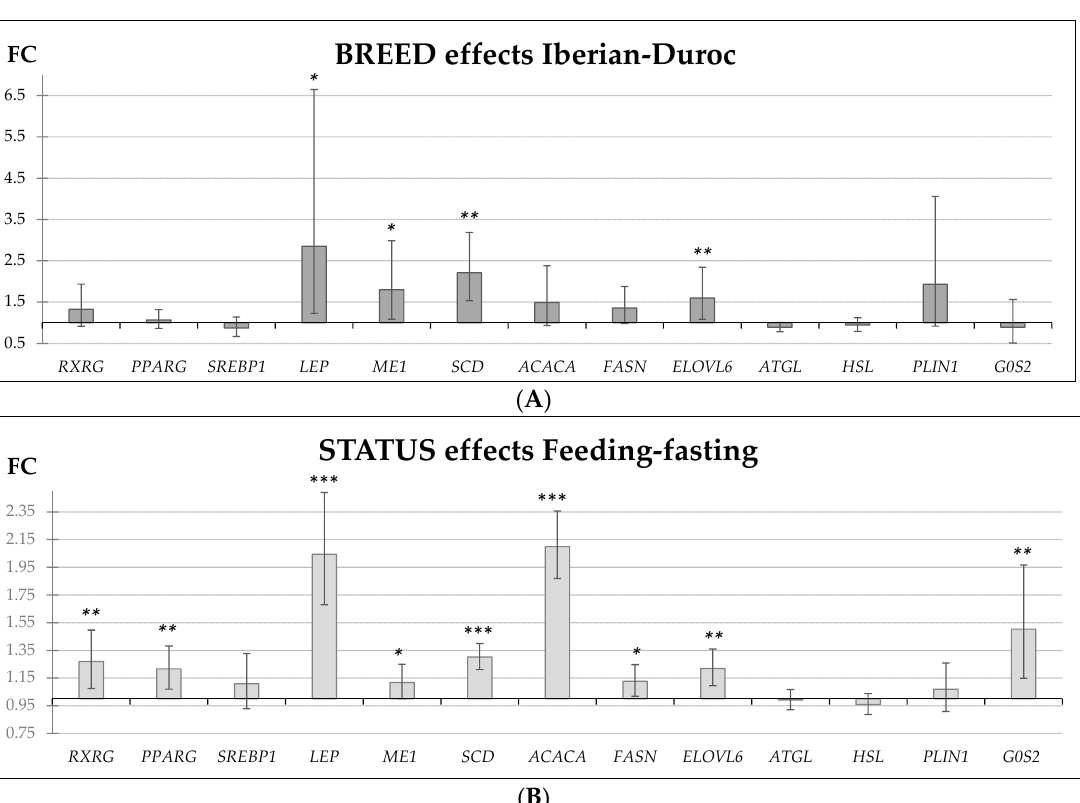
Figure 1. Fold-change ratios (FC) of candidate genes expression in ham subcutaneous adipose biopsies ( A ) Iberian ( n = 29) versus Duroc ( n = 19) ( B ) Feeding versus fasting status ( n = 48). The error lines indicate the standard errors. FC values > 1 indicate higher expression in Iberian pigs and postprandial status. * p < 0.05,** p < 0.001, *** p < 0.0001.